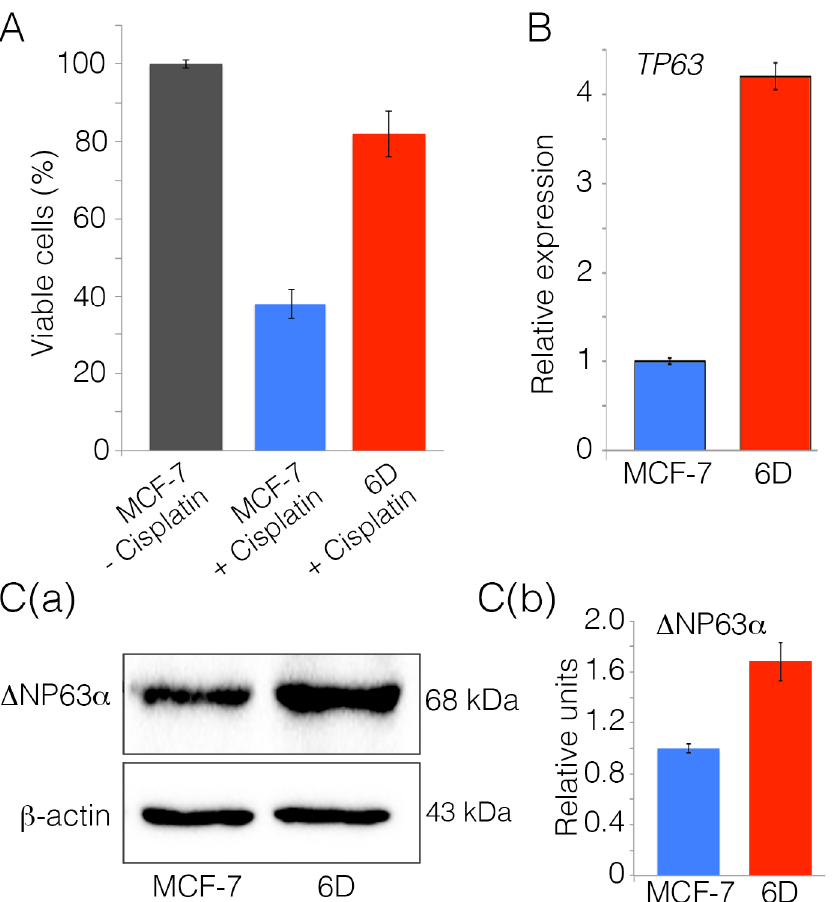
Figure 1. Interleukin 1β (IL-1β) induces resistance to cisplatin and upregulates the expression of TP63 . ( A ) Non-invasive MCF-7 cells and invasive 6D cells were treated with 100 µM cisplatin (MCF-7 + cisplatin) and (6D + cisplatin). MCF-7 cells without any treatment were utilized as the control of live cells in the assay (100% viability). Cells were harvested at 48 h and quantification of viable cells performed using the WST-1 reagent. Data are presented as percentage ± SD of viable cells relative to untreated cells from three independent experiments. ( B ) Relative expression of the TP63 gene was determined by qPCR in MCF-7 and 6D cells. Results represent the average of three independent experiments ± SD. ( C ) (a,b) Representative Western blot and densitometry analysis of total extracts from MCF-7 and 6D cells. The membranes were challenged with anti-TP63 antibody and anti-β-actin for protein load control. The densitometric analysis shows data in three blots from independent experiments. In all of them, ΔNp63α levels were normalized relative to the protein levels in MCF-7 cells. Asterisks indicate significance at p = 0.001.